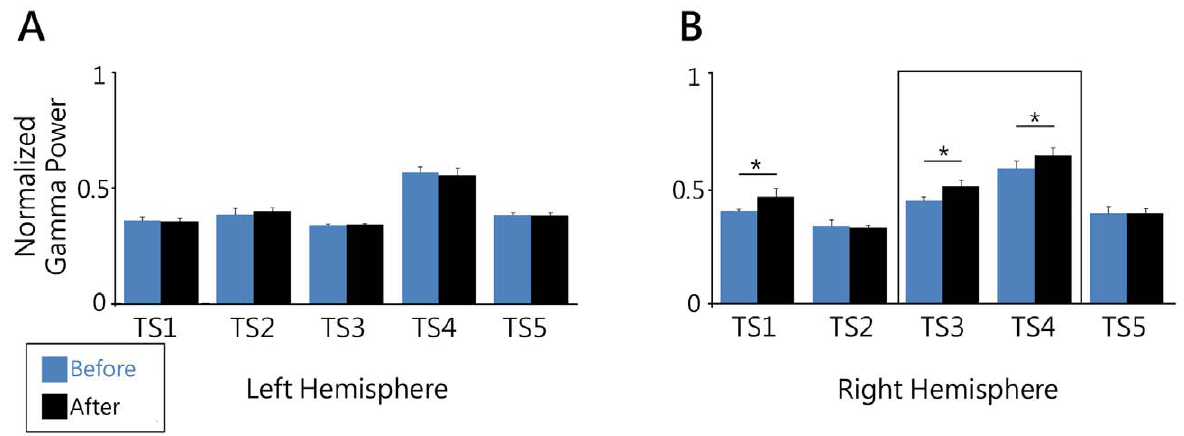
Figure 5. Spectral difference plots were computed to visualize changes in gamma power following acute stimulation. Power spectra for each channel were averaged for 60 seconds proceeding and following 30 seconds of continuous stimulation in each patient. Gamma band power measured before stimulation was compared to gamma band power after stimulation. A) Spectral differences in all patients from channel four in the Left hemisphere. No subjects showed acute changes in gamma power. B) Spectral difference measured in the right hemisphere. TS1, TS3, and TS4 showed significant increases in gamma power following acute stimulation. Asterisk indicates significance at the 0.05 level. Box indicates TS3 and TS4 as best